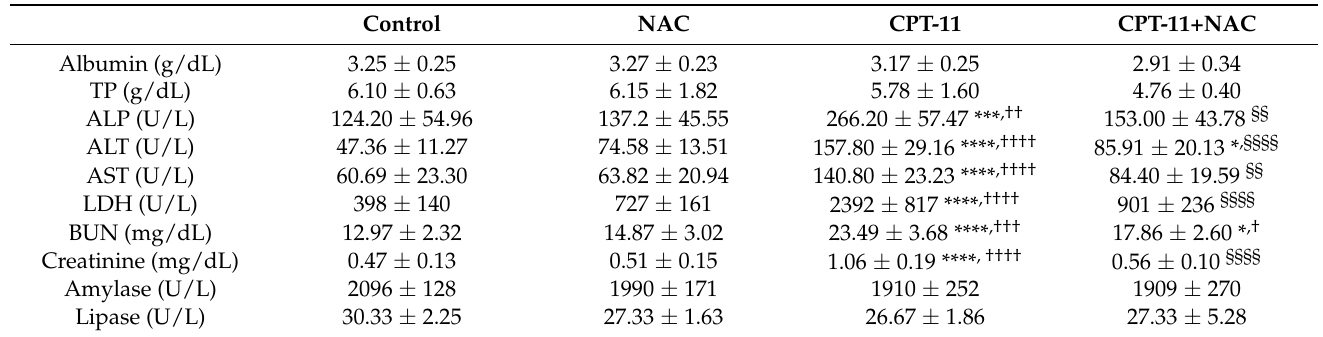
Table 1. Changes in serum enzymes and metabolites in the sera of rats (mean ±